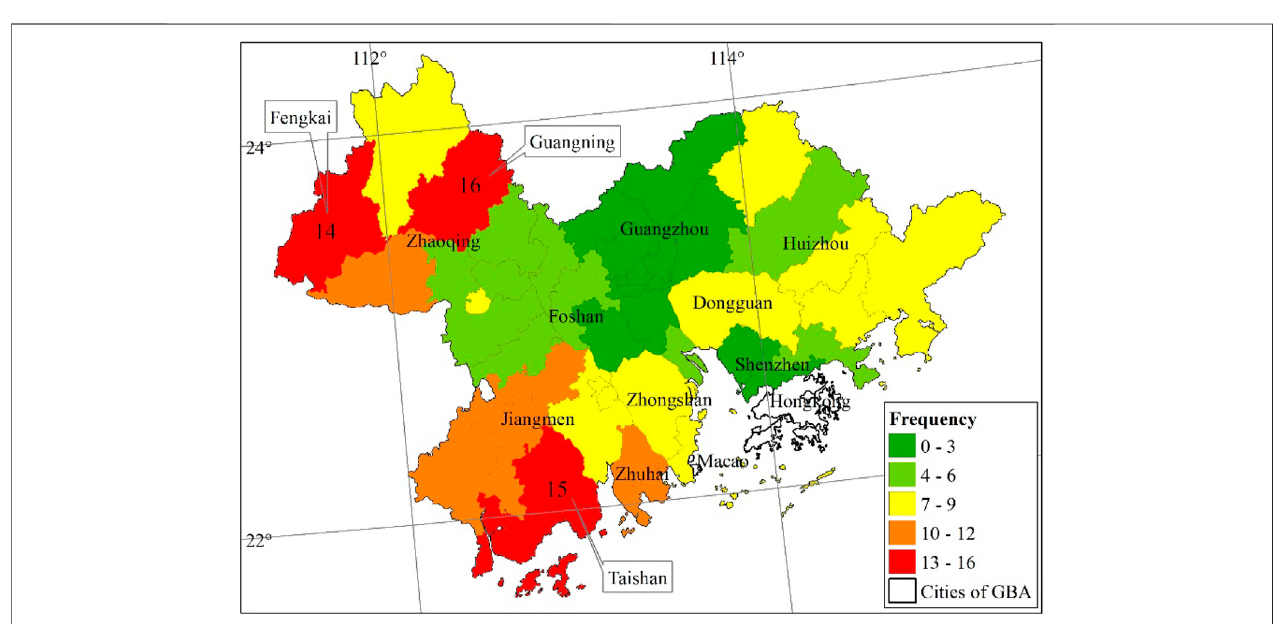
FIGURE 4 | Frequency distribution of total disaster-causing typhoons at county level in the GBA from 2009 to 2020.